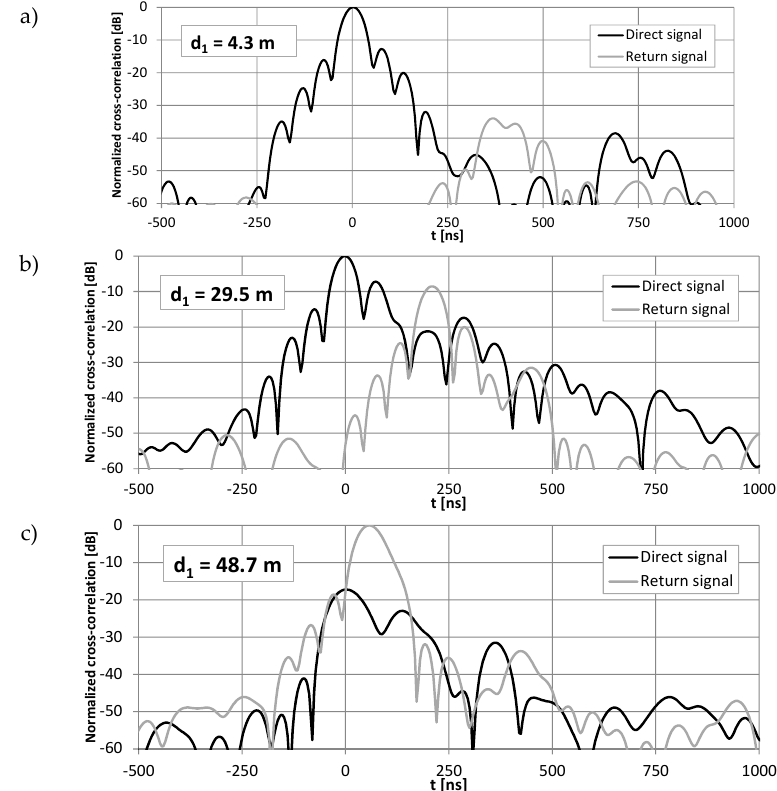
Figure 9. Examples of cross-correlation functions of direct and return signals recorded at d 1 = 4.3 m ( a ), 29.5 m ( b ) and 48.7 m ( c ) using two radiating cables with frequency conversion.